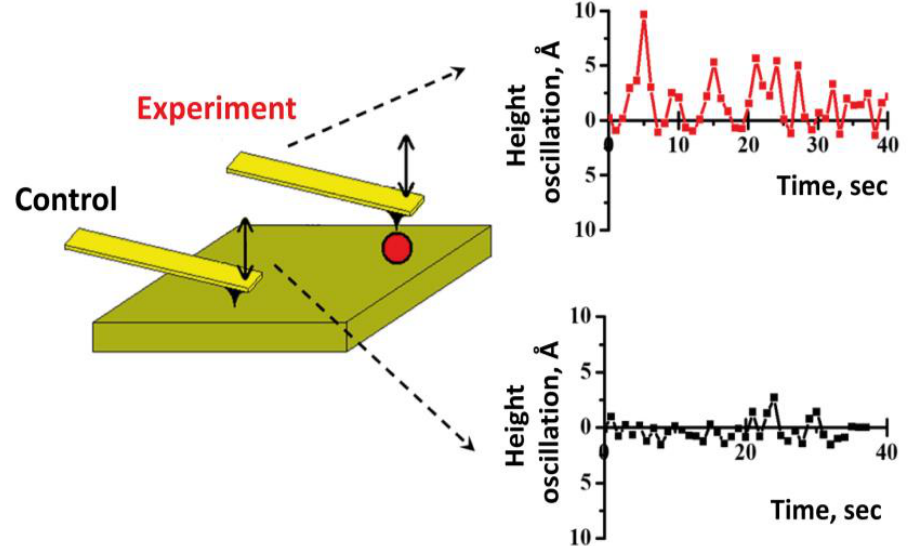
Figure 2. Monitoring the height of a single molecule during functional activity by AFM.